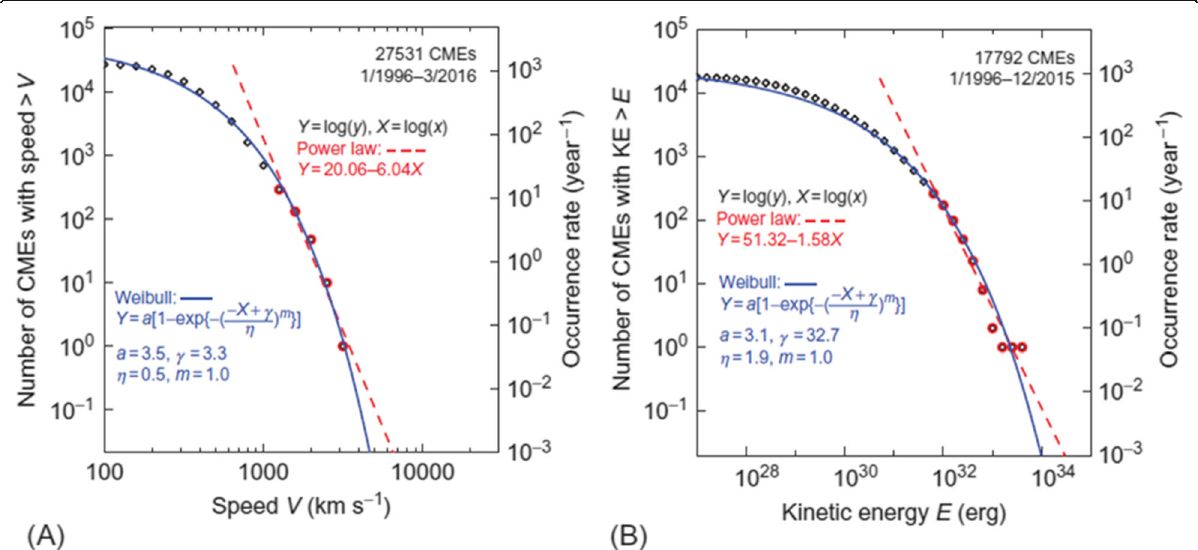
Fig. 5 Cumulative distribution of CME speeds ( a ) and kinetic energies ( b ) from SOHO/LASCO catalog (https://cdaw.gsfcs.nasa.gov) for the period